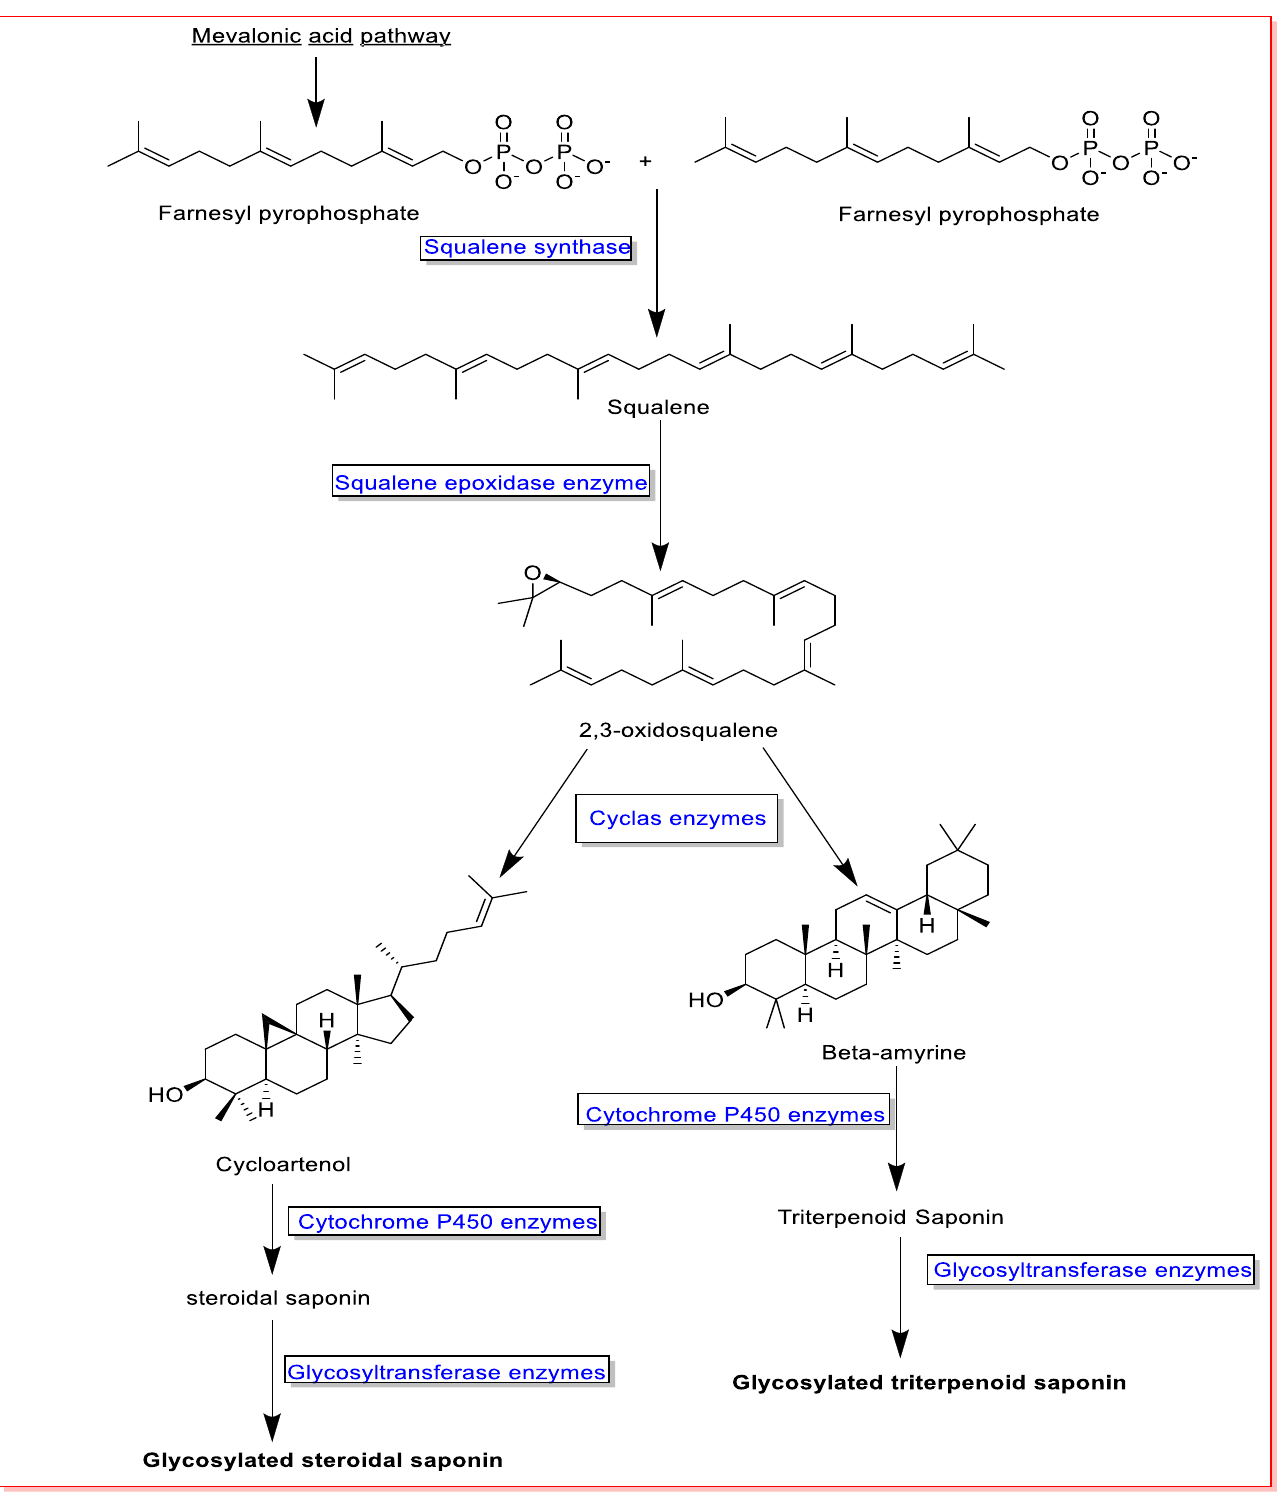
Figure 1. An overview on saponin biosynthesis pathway.